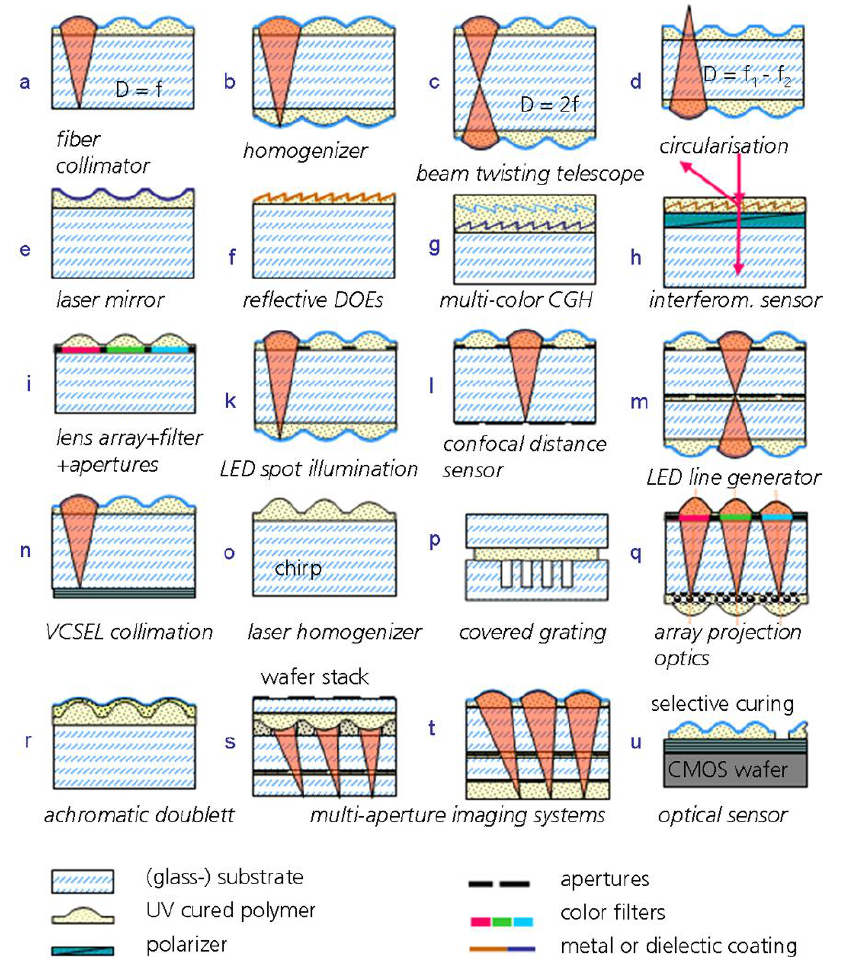
Figure 10. Survey of realized micro-optical modules shown as schematic cross